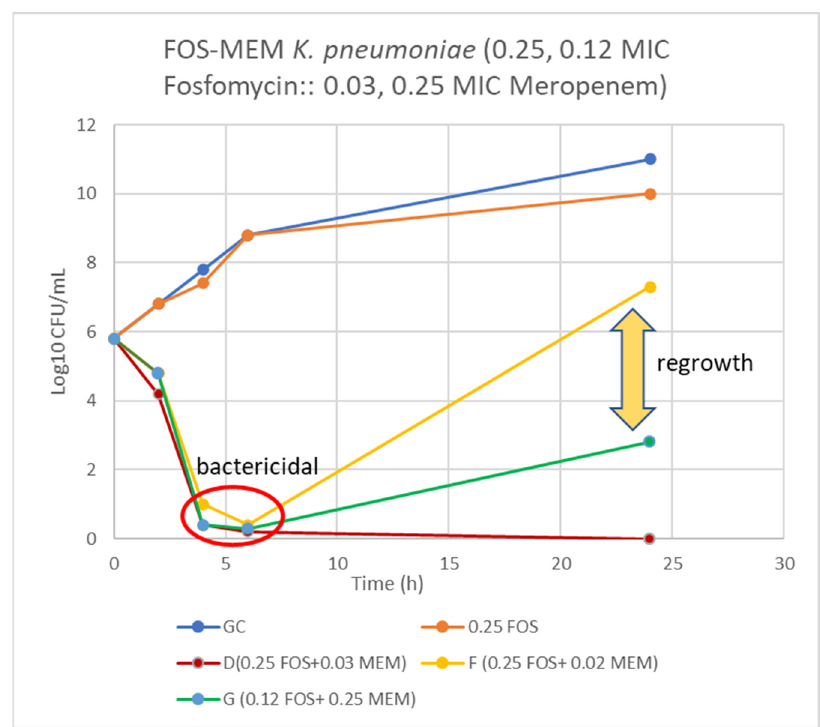
Figure 1. Time-kill curve of K. pneumoniae (Kp 4) using 0.25 and 0.12 MIC fosfomycin alone and combined with 0.03, 0.02, and 0.25 MIC meropenem. D = bactericidal effect at 6–24 h, F = bactericidal at 6 h and G = bactericidal at 4–6 h and synergy at 24 h incubation.